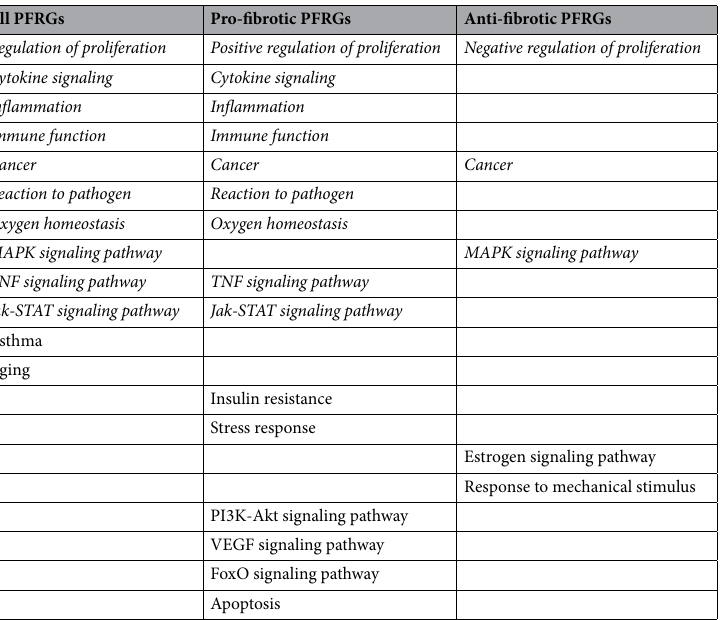
Table 4. Processes and pathways enriched in pulmonary fibrosis-related genes (PFRGs). For a full enrichment analysis see Supplementary Table ST4. Italicised areas that are common to all, pro-fibrotic, and anti-fibrotic PFRGs.